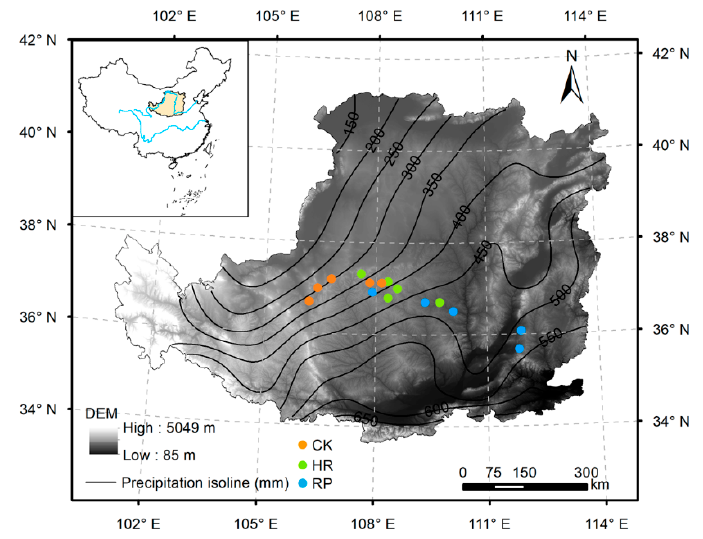
Figure 1. Location of sampling sites along the precipitation gradient in the Loess Plateau. Mean annual precipitation was derived from a precipitation map based on 273 meteorological stations across the entire Loess Plateau (Climate Database, National Meteorological Information).